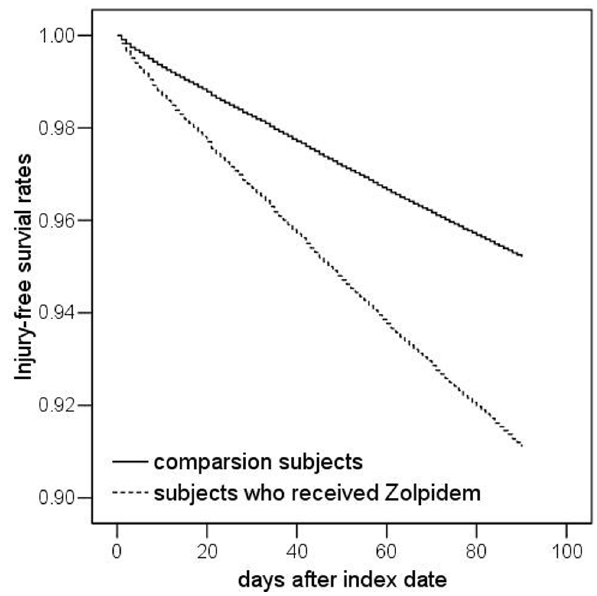
Figure 1. Injury-free survival rates for subjects who were prescribed Zolpidem treatment and the comparison subjects.